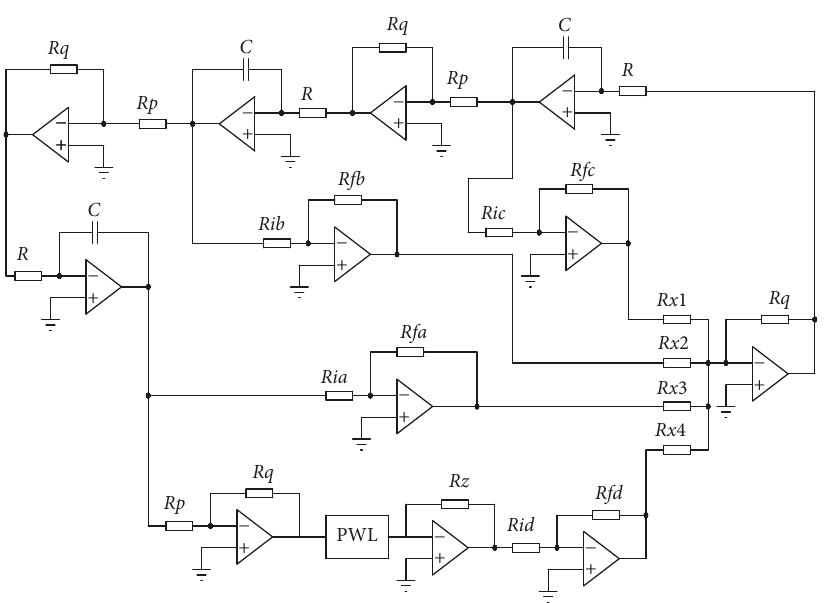
Figure 4: Realization of (1) using